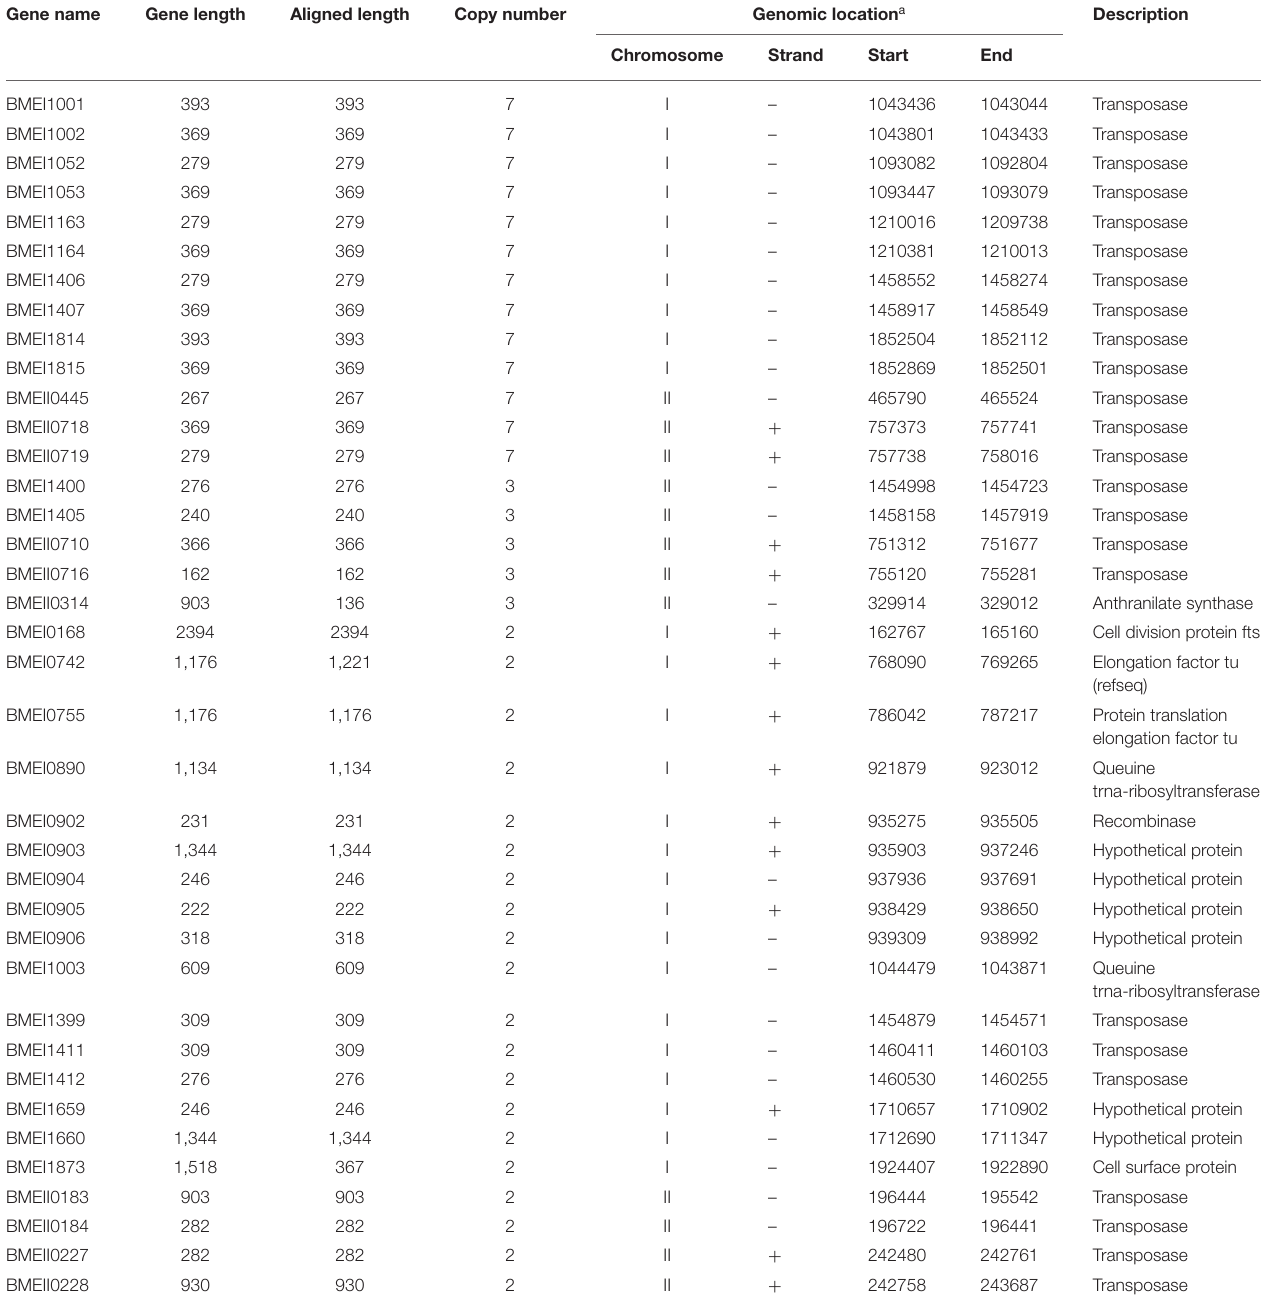
TABLE 1 | Multi-copy genes in genome of B. melitensis